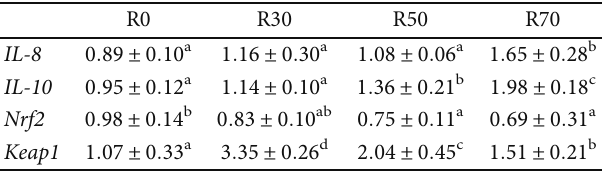
Figure 4: Hindgut morphology of grass carp fed practical diets. (a) the hindgut morphology of R0; (b) the hindgut morphology of R30; (c) the hindgut morphology of R50; (d) the hindgut morphology of R70. Table 9: Reactions of mRNA gene expressions in hindgut of grass carp fed practical diets ( means ± SD , n = 4